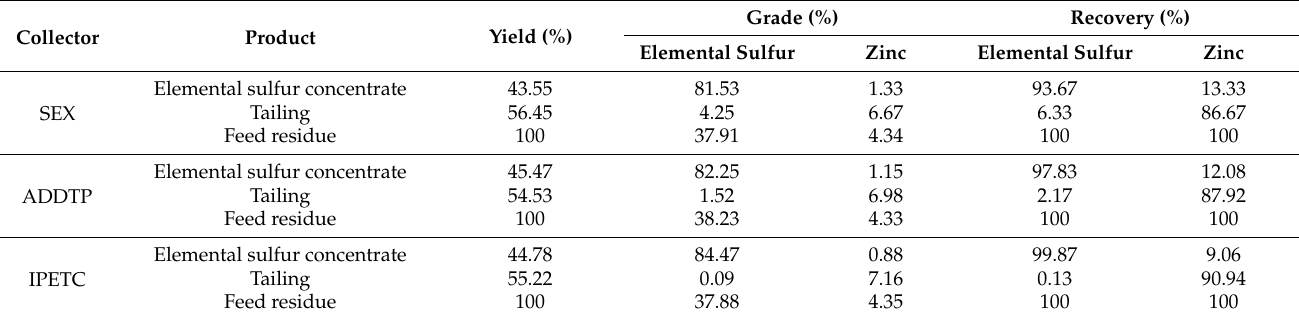
Table 6. The result of closed-circuit flotation of the high-sulfur residue with IPETC, ADDTP and SEX